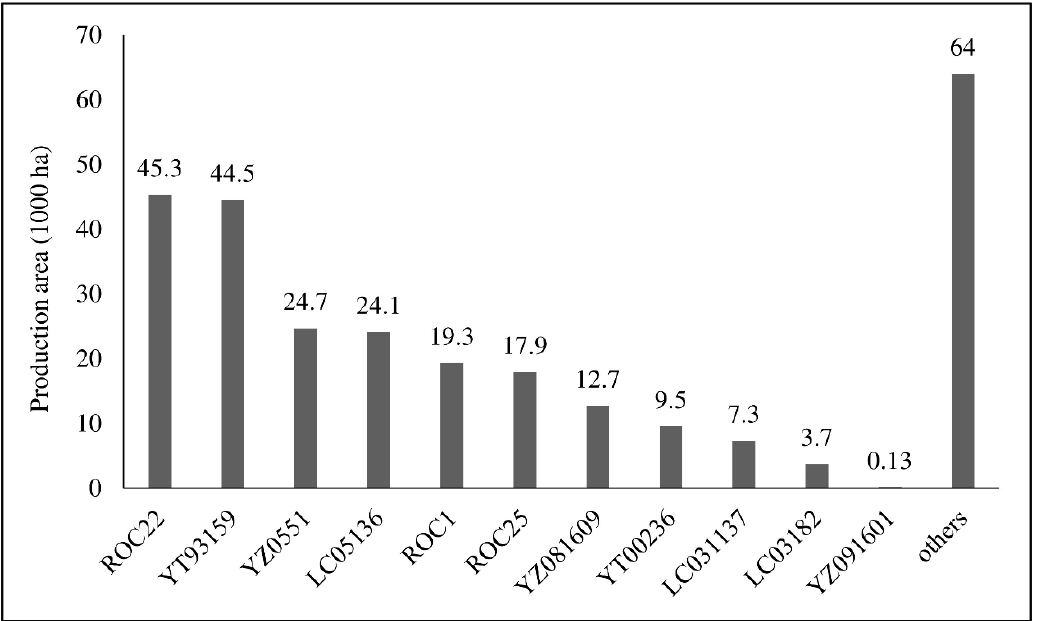
Figure 4. Area of sugarcane planting in Yunnan Province in 2020 by variety.